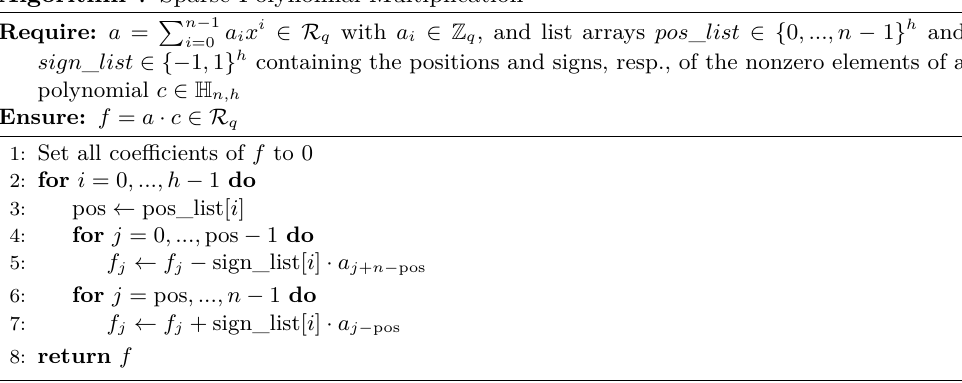
Algorithm 7 Sparse Polynomial